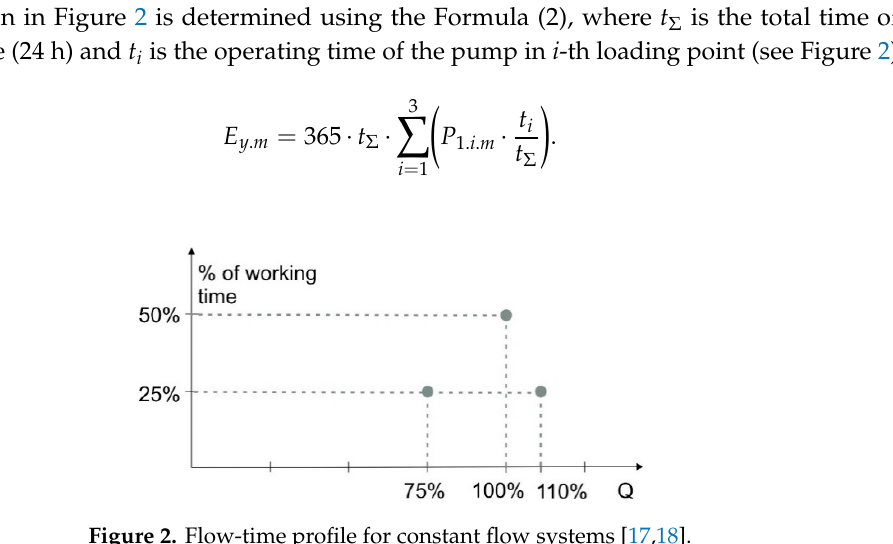
Figure 2. Flow-time profile for constant flow systems [17,18].